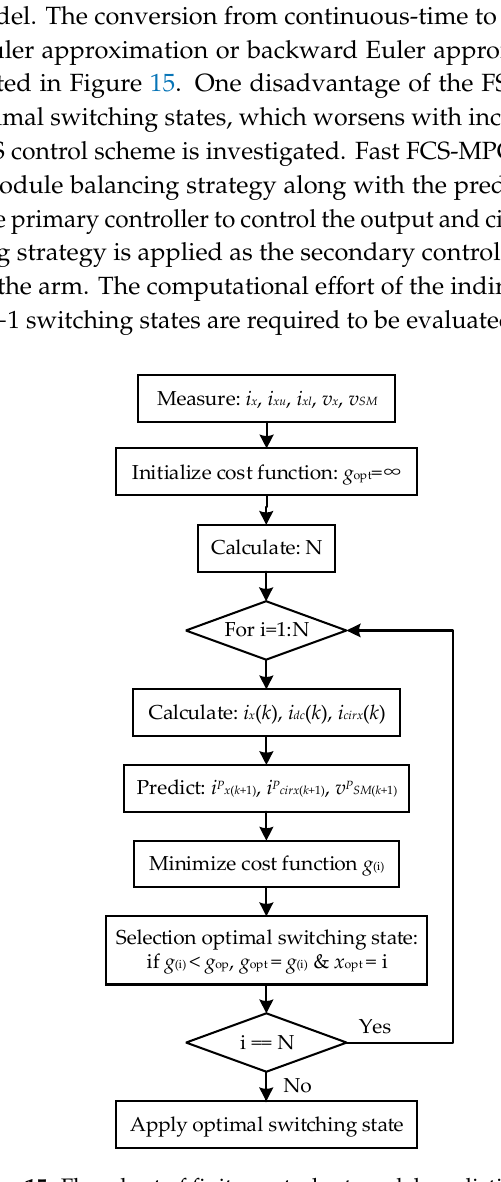
Figure 15. Flowchart of finite control set model predictive control .